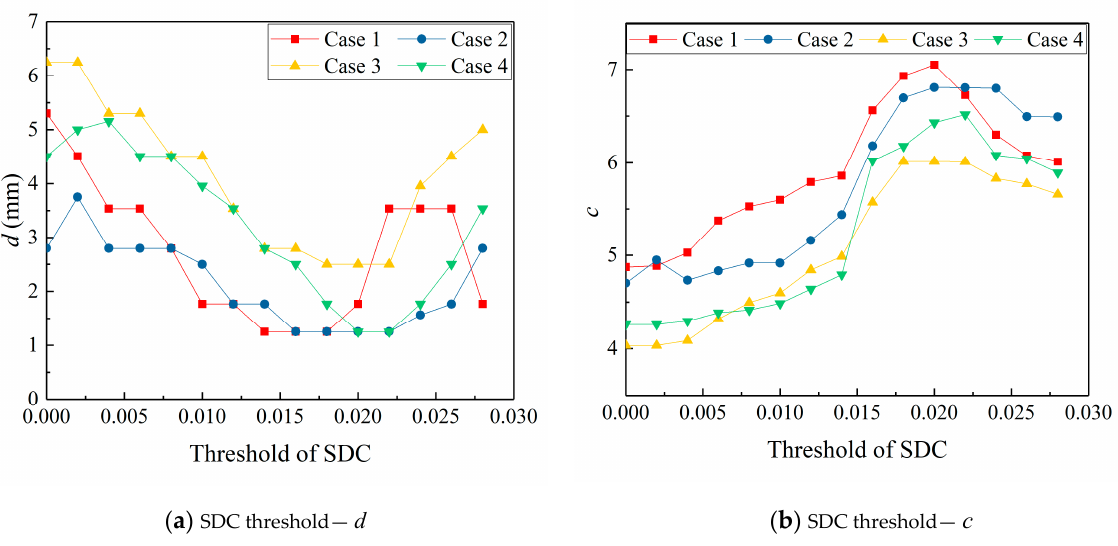
Figure 14. Imaging location deviation and degree of aggregation under different SDC thresholds. In Table 3, the defect location error and aggregation coefficient of the traditional probabilistic ellipse imaging algorithm, the probabilistic ellipse imaging algorithm